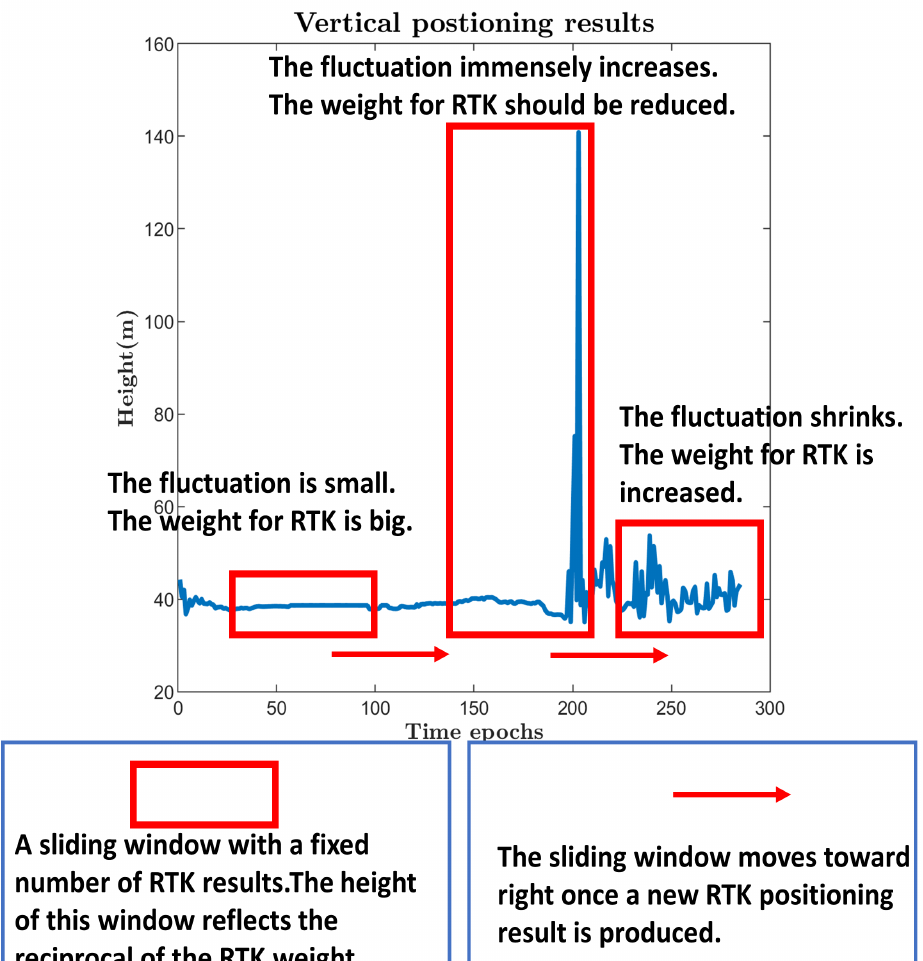
Figure 5. The illustration of the improved integration